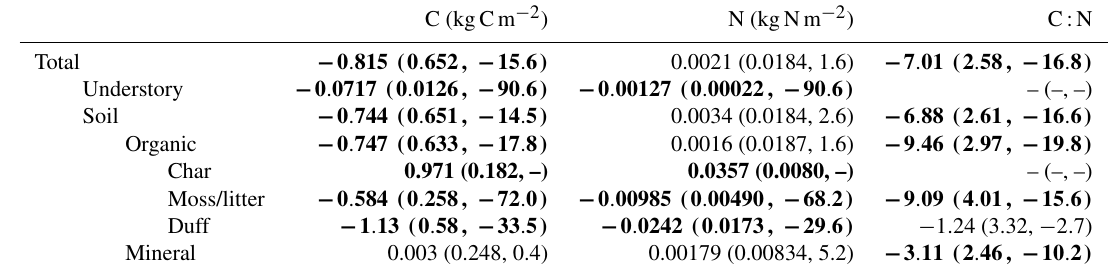
Table 3. Mean values of distributions ( n = 50) formed by subtracting control plot variables from their paired burnt plot. In parentheses are first the 95% confidence interval of the distribution and then the percentage change calculated from the overall means of control and burnt plots. Statistically significant fire-induced changes are in bold.